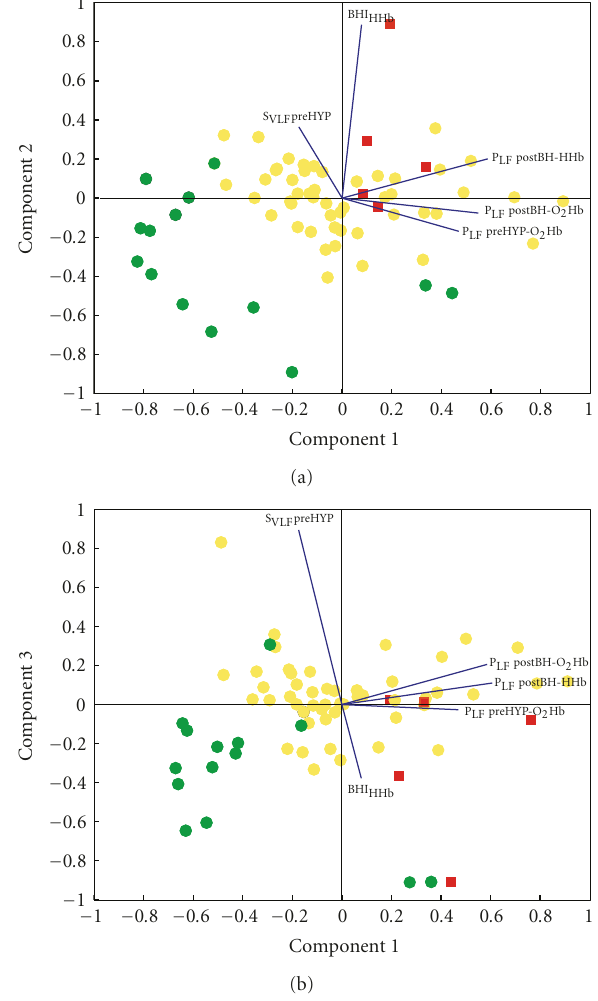
Figure 3: Principal component representation of the subjects in the hyperplanes formed by (a) the 1st and 2nd components, and (b) the 1st and 3rd components. Red squares indicate the healthy controls, green circles the migraine without aura patients, and the yellow circles the migraine with aura patients. The blue lines represent the loading/loading plot of the PCA: the lines indicate the direction of the original variables in the hyperplanes. The length of the blue lines projected onto the axis is proportional to the weight of the original variable for the specific component. Migraine without aura subjects (green circles) are clearly clustered far from the other